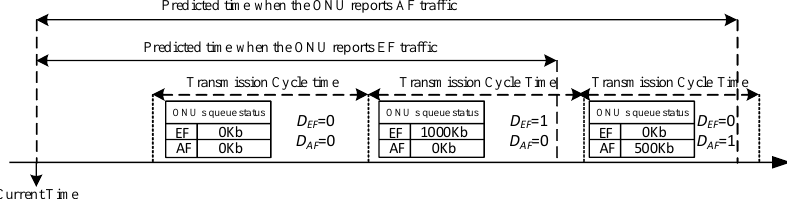
Figure 3. Calculation for 𝐷 𝐸𝐹 and 𝐷 𝐴𝐹 .